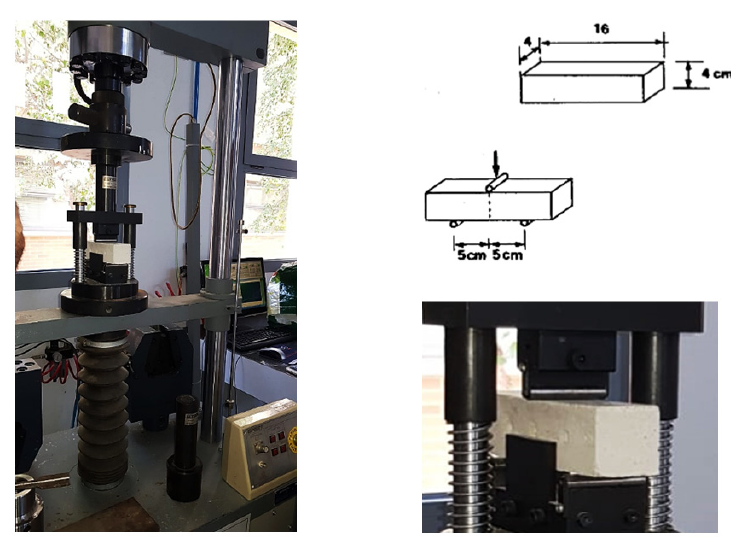
Figure 6. Multi ‐ test machine equipped for the flexural strength test. Figure 6. Multi-test machine equipped for the flexural strength